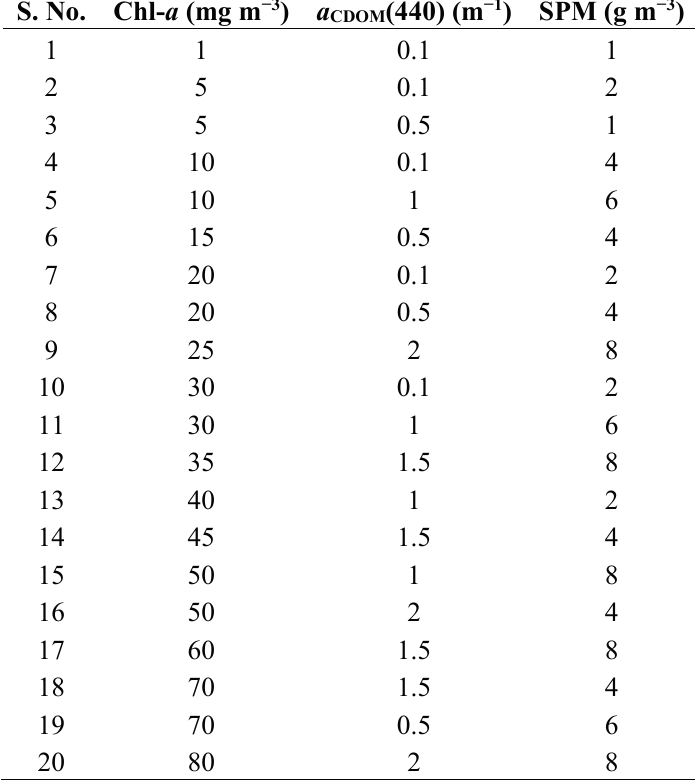
Table 3. Constituent concentrations considered for the analysis of the effect of sensor noise on the water quality parameters retrieved through the non-linear least squares error minimization